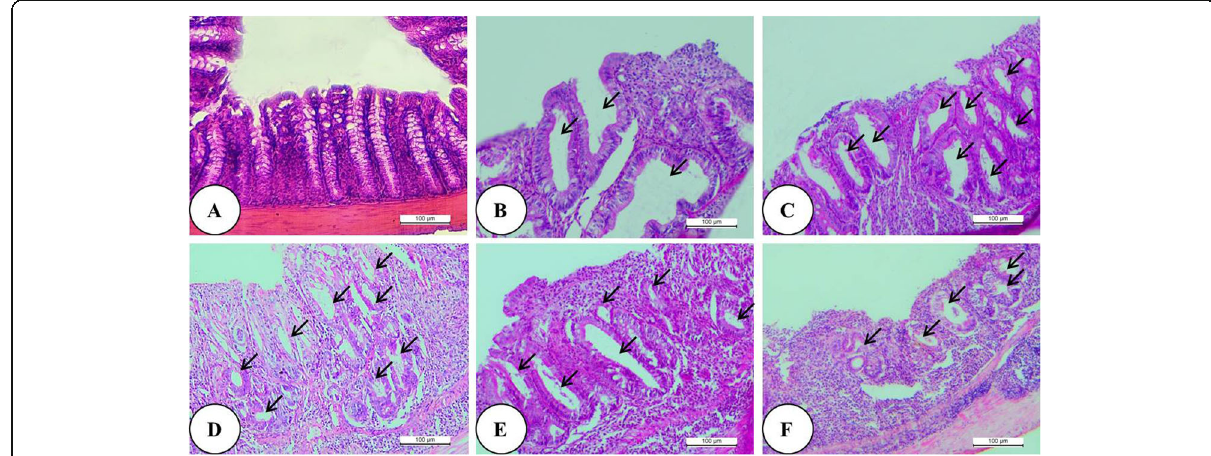
Fig. 7 Histopathology of colon tissue sections stained with hematoxylin and eosin. A NC shows normal colonic mucosa. B PC group with maximum tumoral growth with tubular adenocarcinoma in the 12-week study period. C IRN group showing reduction in adenocarcinomatous growth. D GT group showing higher number of tubular adenocarcinoma as compared to the IRN group. E IRN+GT Low group showing decrease in tubular adenocarcinoma as compared to the IRN group. F IRN+GT High group showing decrease in tubular adenocarcinoma as compared to the IRN group along with cellular apoptosis. (Arrow head represents differentiation of tubular